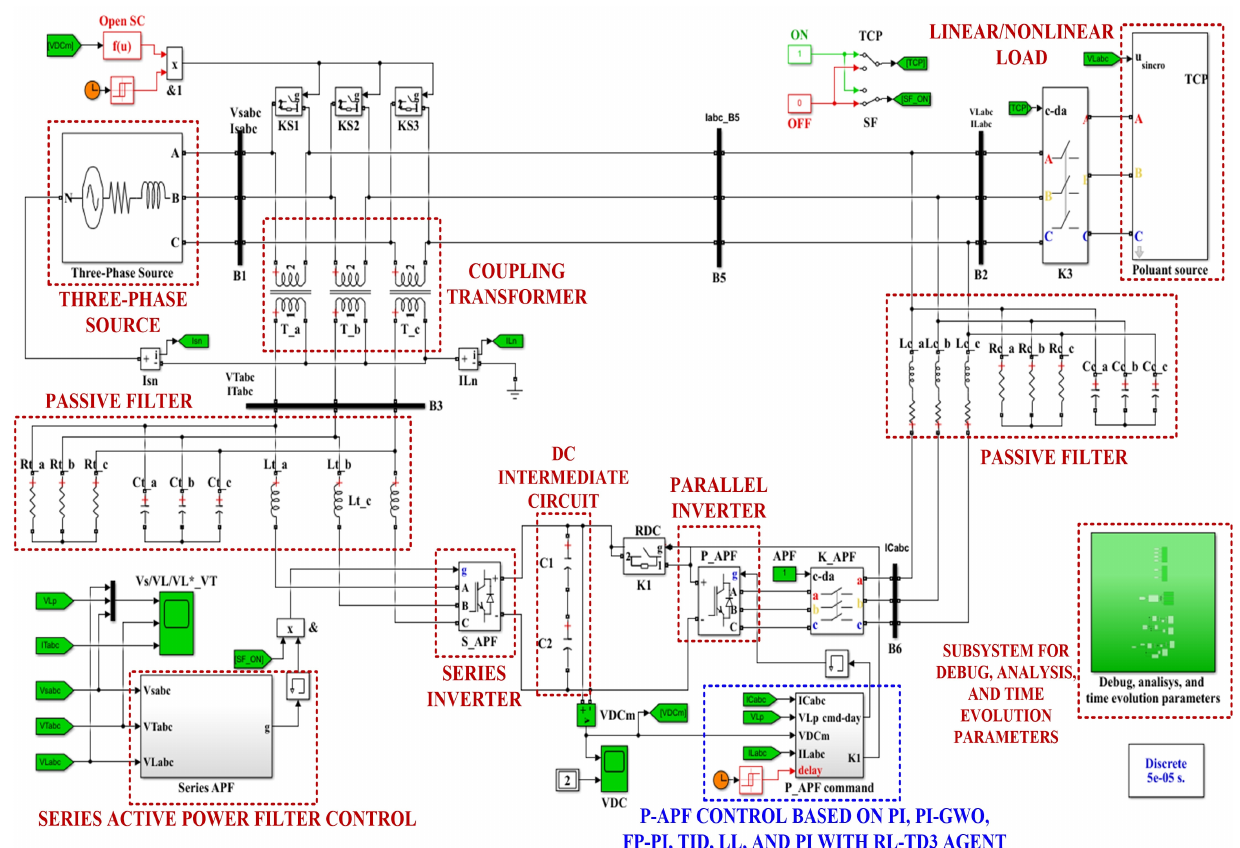
Figure 3. MATLAB/Simulink implementation of the UPQC system.